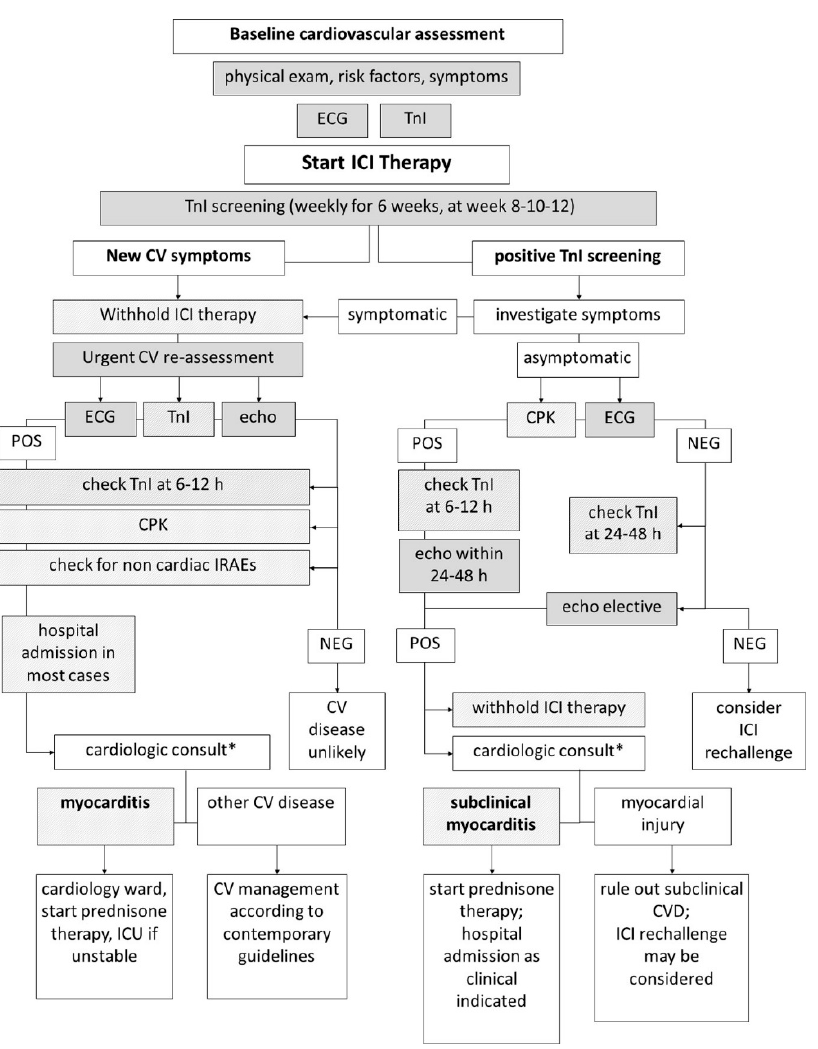
Figure 7. Algorithm for early detection of ICIs related myocarditis proposed by Spallarossa et al. The timing of troponin assays repetition differs due to the presence/absence of symptoms. * Result of integration and interpretation of clinical, anamnestic, laboratory, ECG and echocardiographic data [53].